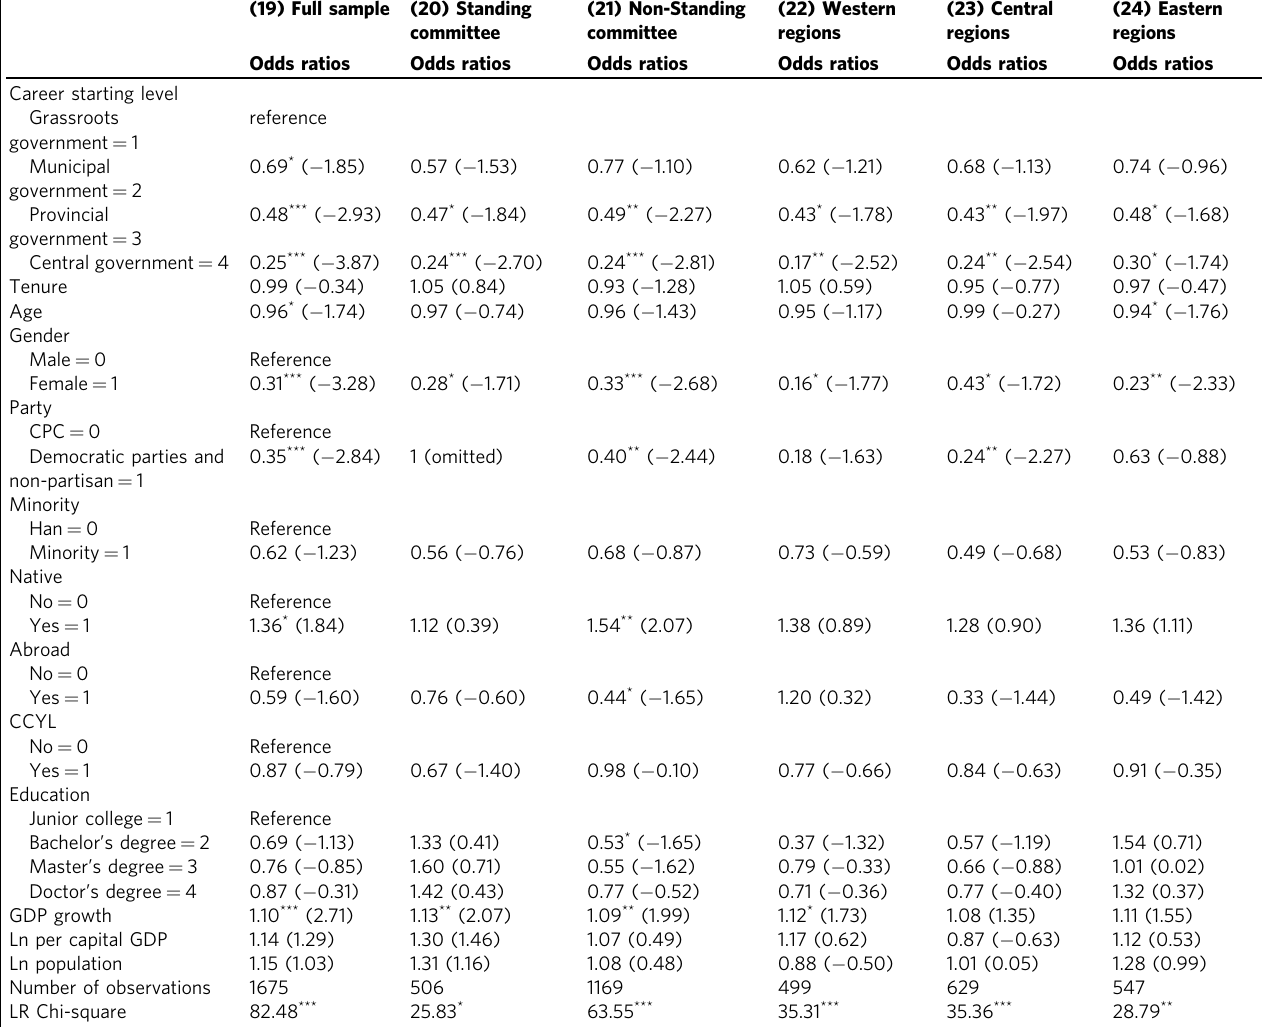
Table 5 The logistic regression results estimating the effect of different career starting levels on political falling. (19) Full sample (20) Standing